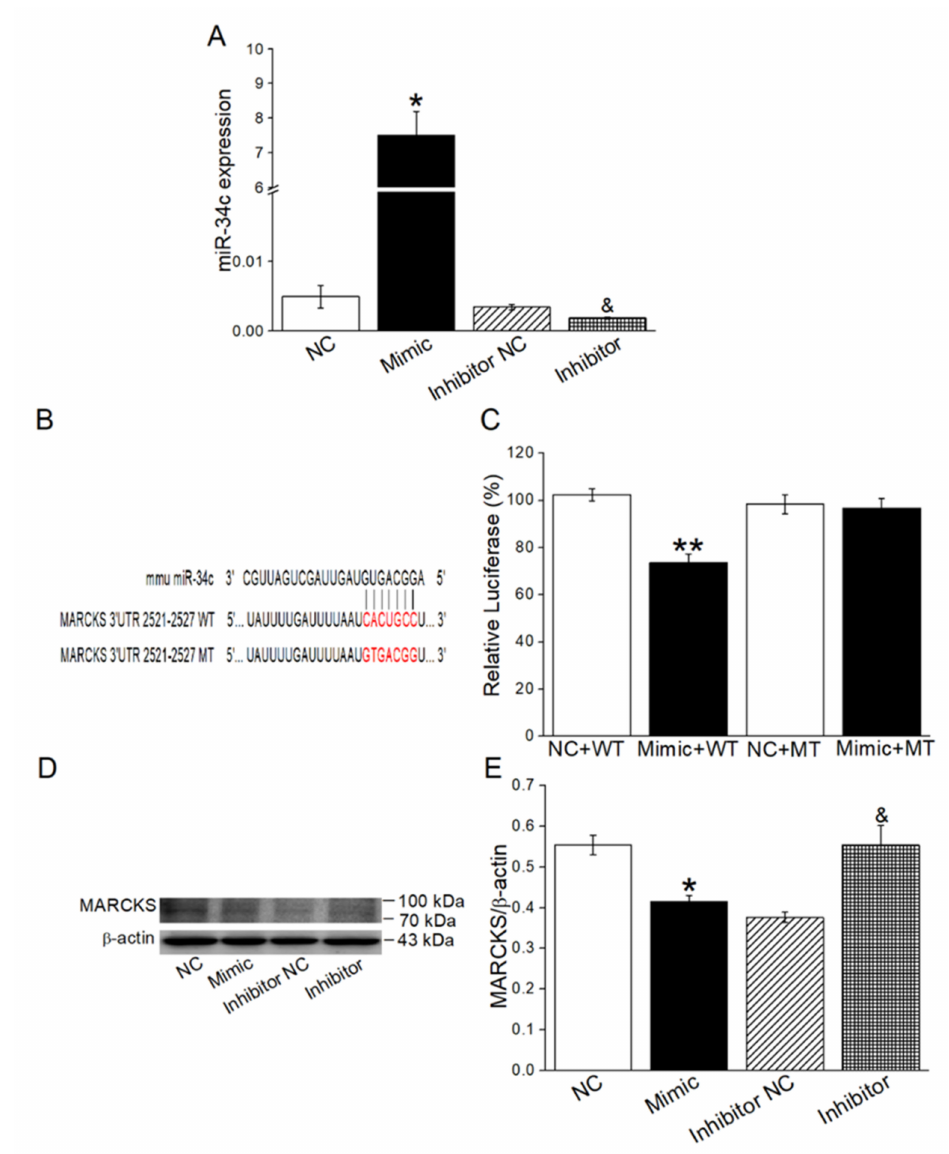
Figure 5. MiR-34c could bind directly to MARCKS. ( A ) Transfection efficiency of miR-34c in H441 cells ( n = 4). ( B ) The potential binding sites for miR-34c on the 3 (cid:48) -UTR of MARCKS. ( C ) Dual luciferase assay for miR-34c binding with MARCKS. H441 cells were co-transfected with miR-34c mimic negative control (NC) or miR-34c mimic (Mimic) together with pmirGLO-MARCKS (WT or MT) for 24 h ( n = 4). ( D ) Representative Western blot measurement of MARCKS protein expression in H441 cells transfected with miR-34c mimic/inhibitor. ( E ) Graphical representation of data obtained from Western blot assays for MARCKS and quantified through gray analysis (MARCKS/ β -actin) ( n = 4). Note: * p < 0.05, compared with NC group; ** p < 0.01, compared with NC + WT group; & p < 0.05, compared with Inhibitor NC